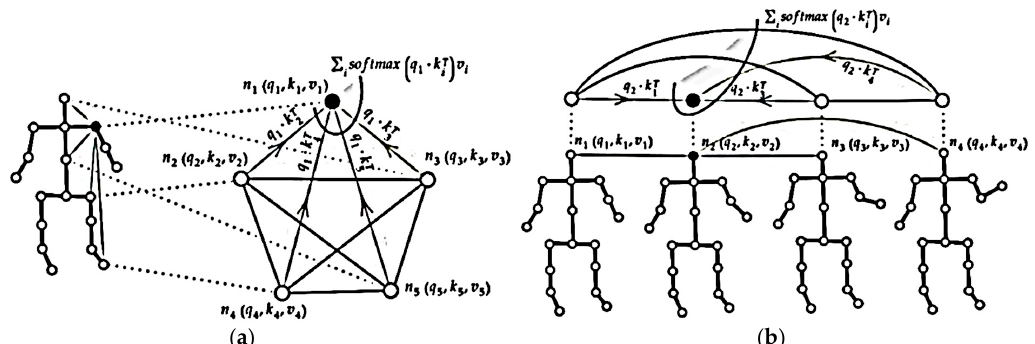
Figure 8. Two-stream Transformer network: ( a ) Spatial Self attention; and ( b ) Temporal self- attention Modified [82].